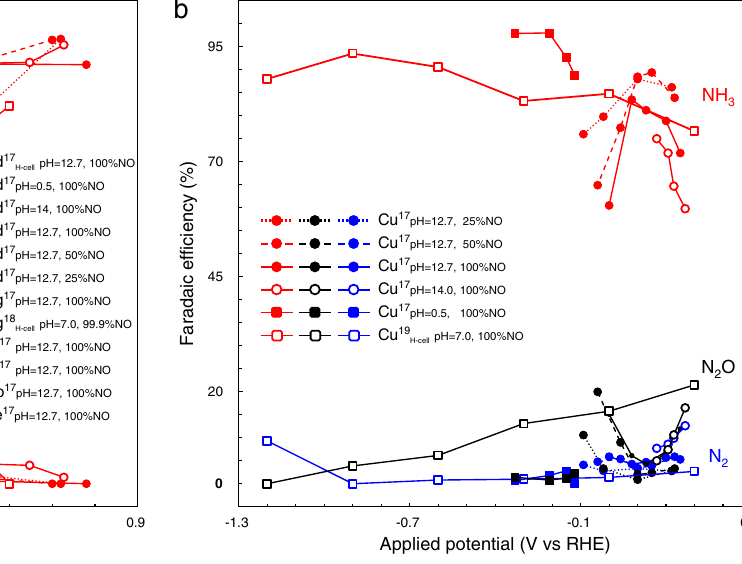
Fig. 1 | Overview of different catalysts in eNORR compiled from the recent reports 17 – 19 . a The Faradaicef fi ciency(FE)of N 2 O and N 2 at low overpotentials (0.8 to − 0.3V vs. RHE) on Pd, Ag, Pt, Ni, Co, and Fe. b A higher FE of NH 3 than dual-N products (N 2 O/N 2 ) on Cu in a wider potential window (from 0.3 to − 1.2V vs. RHE).